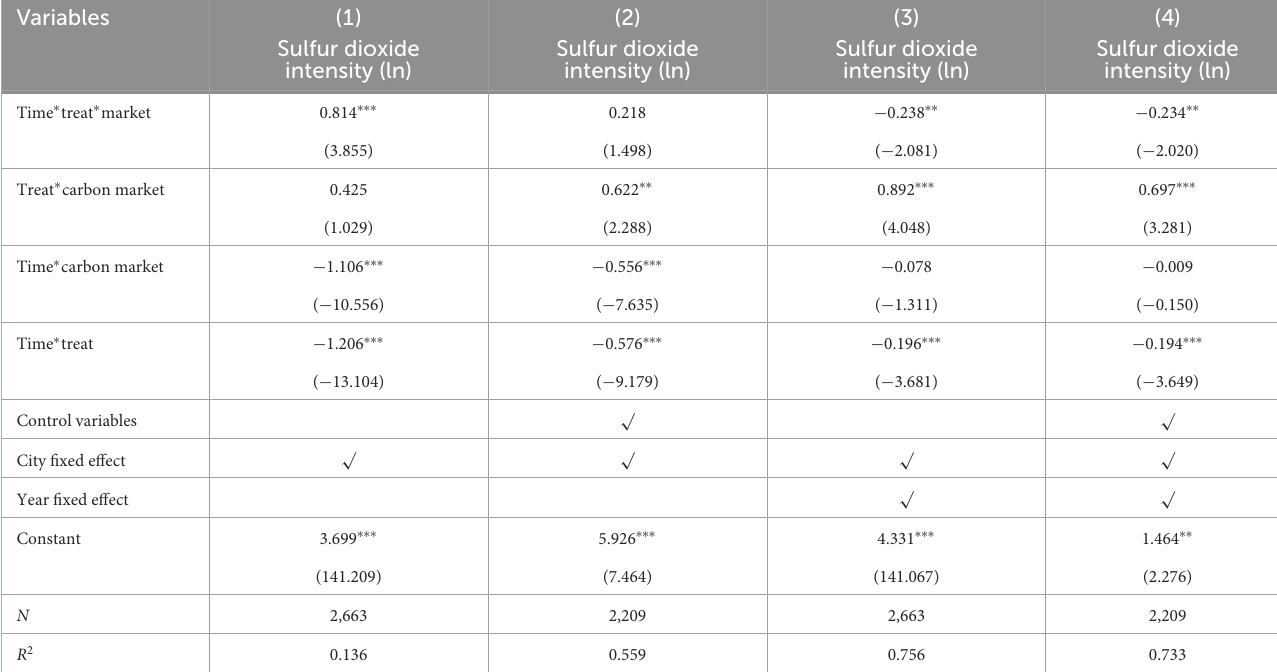
TABLE 6 DDD test estimates.